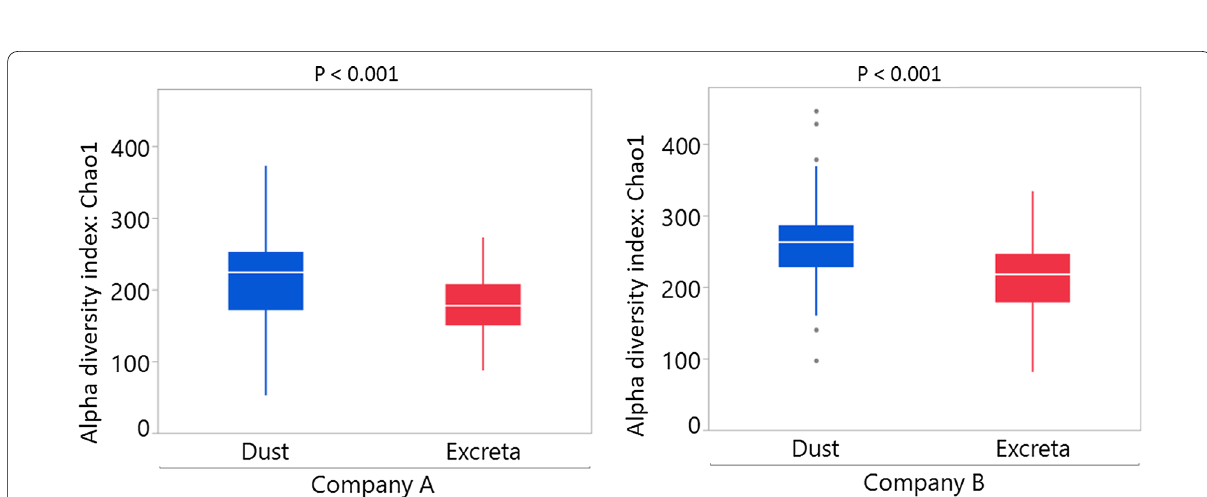
Fig. 2 Microbial richness estimated using Chao1 diversity index for dust and excreta of companies A and B. All ages were combined for the